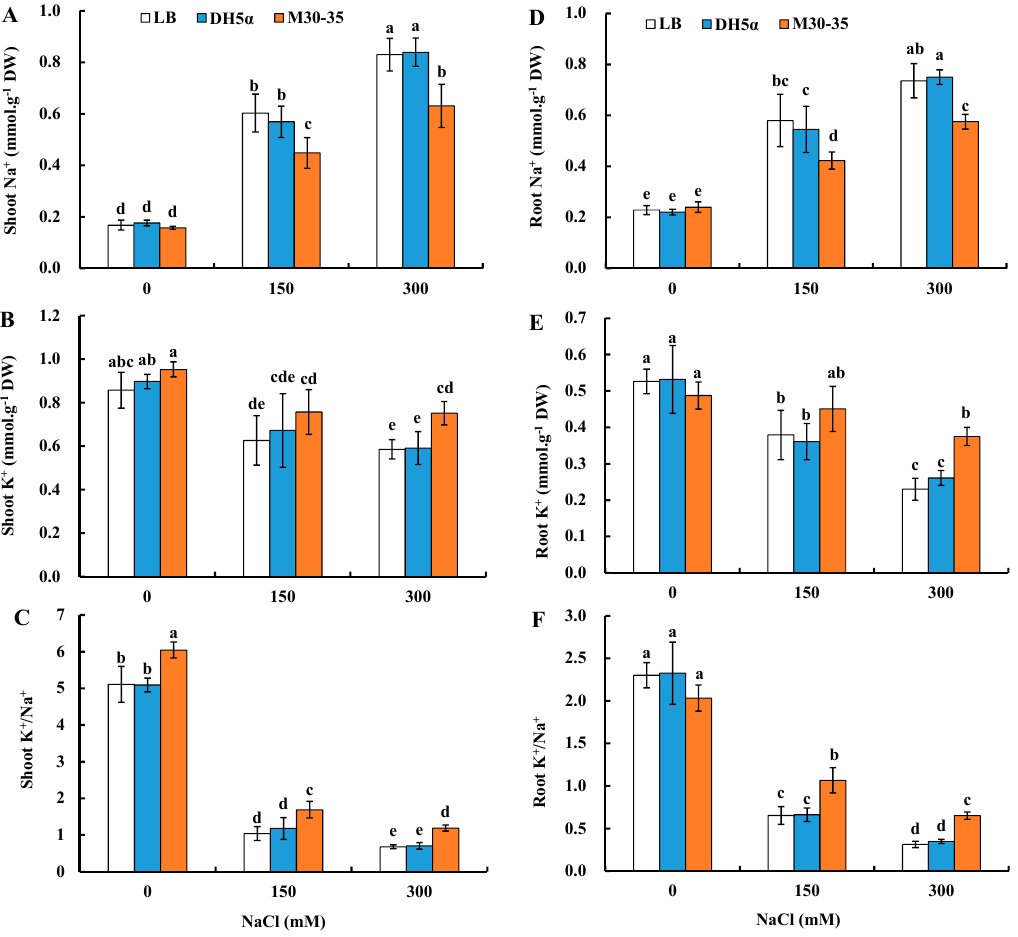
Figure 7. Effects of M30-35 on tissue Na + ( A , D ) and K + ( B , E ) contents and K + /Na + ( C , F ) ratio of ryegrass under various salt conditions (0, 150 and 300 mM NaCl). Values are means and bars indicate SEs ( n = 12). Columns with different letters indicate significant differences among treatments at p < 0.05 (ANOVA and Duncan’s multiple comparison test).